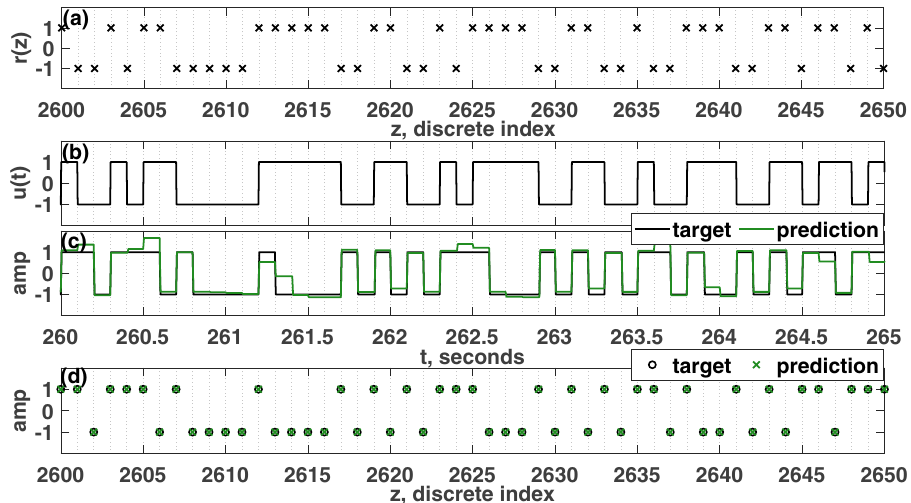
Figure 2. ( a ) Discrete random binary signal, r ( z ). ( b ) Continuous input signal, u ( t ). ( c ) target signal and continuous prediction. d) Discretized target and prediction. The calculated information metric is R = 0.98 . For the simulation depicted here, the parameters were set such that: µ = 5 , A = 0.5 , � = 40 π rad/s, ω 0 = 40 π rad/s, T p = 0.1 s, N = 20 , φ = π/ 3 rad, σ = 100 , β = 1.0